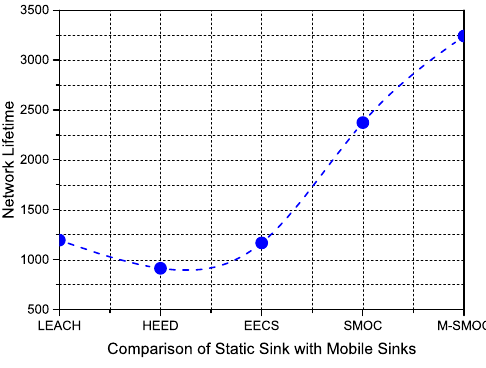
Figure 5. Comparison of the proposed mobile sink with existing static sink over network lifetime